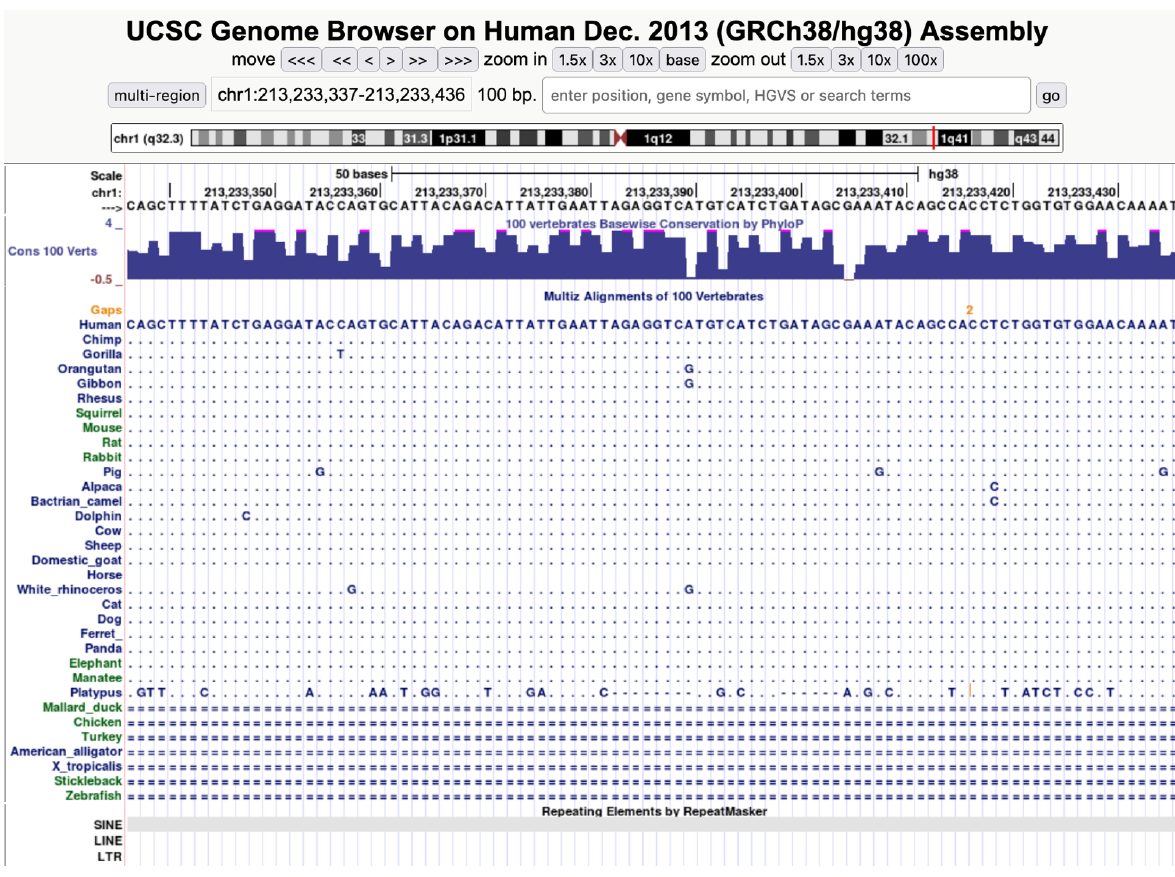
Figure 1. Example of evidence for ancient vertical conservation of a high-identity human vs. domestic animal SINE hit in UCSC Genome Browser. The human sequence is represented horizontally by base pair, while alignments for various domestic and wild animal species are matched by base pair position below; dots indicate conserved nucleotides, while SNPs are shown as the modified base against human. Dashes indicate gaps (absence or truncation of the element). A horizontally transferred element would have extremely high sequence similarity in human and the target species while having a lower identity in species related to the host and being absent in species related to the target. Accessed on 30 July